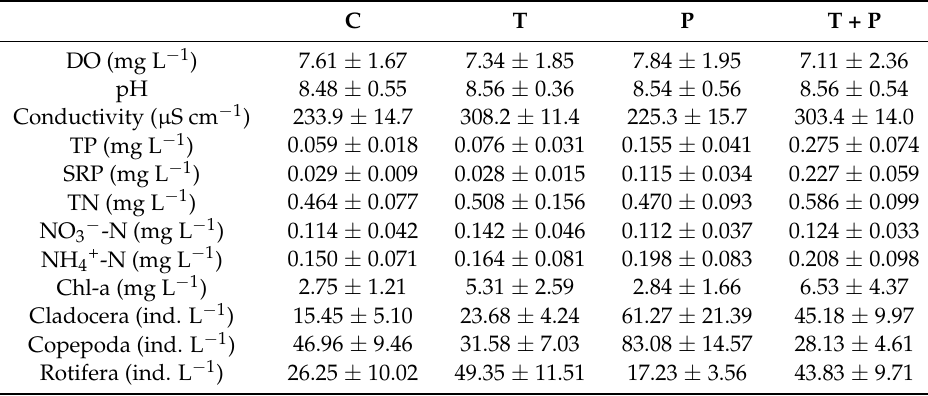
Table 1. Mean water chemistry and zooplankton abundance from mesocosms under the C, T, P, and T + P treatments. Values were calculated from weekly measurements of six replicate ( n = 6) mesocosms in July and August 2014. Values are means ± SD (standard deviation). Abbreviations used: Control, C; water temperature increased 4.5 ◦ C compared with the control, T; addition of 50 µ g L − 1 phosphate every 2 weeks, P; addition of 50 µ g L − 1 phosphate every 2 weeks and temperature increase of 4.5 ◦ C, T + P; dissolved oxygen, DO; orthophosphate, SRP; total phosphorus, TP; total nitrogen, TN; chlorophyll-a, Chl-a. (Note: ind. L − 1 is the abbreviation of